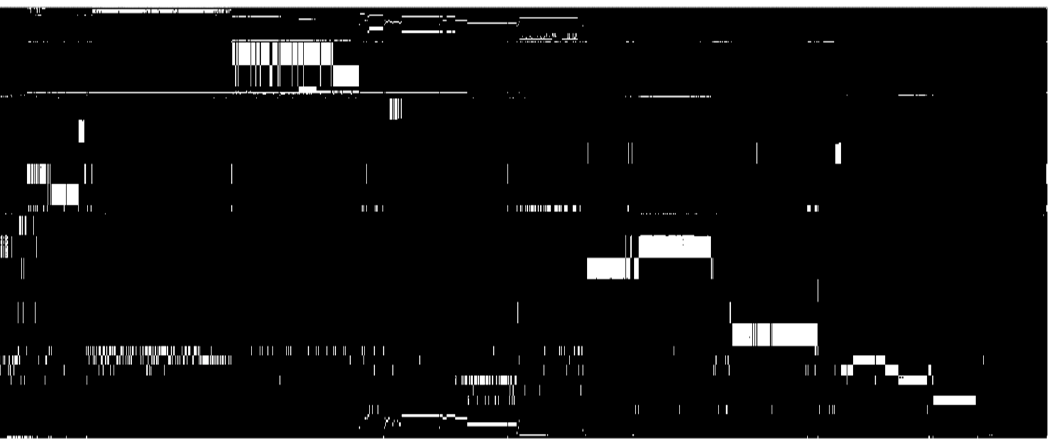
Figure 5. Uneven phenotyping in United States sorghum collection. Columns contain 2378 accessions with genomewide SNP data. Rows contain one trait measured in one study (787 rows). The same trait may occur multiple times in the matrix, measured in independent studies. White indicates a measurement, black, missing data. Horizontal white traces indicate traits that have been measured for many accessions in a single study. Vertical traces mark accessions that have been measured for many traits.